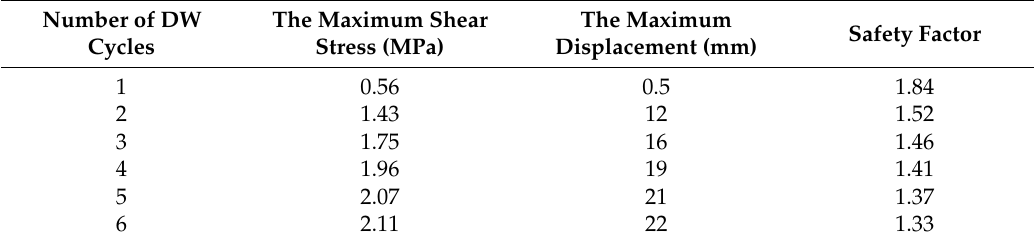
Table 3. Tailings dam calculated results after DW cycles.